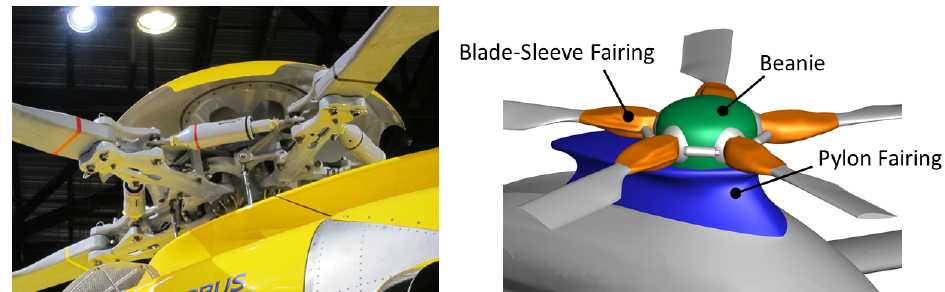
Figure 2. Airbus Helicopters H175 rotor head without fairings [24] ( left ) and RACER full fairing concept ( right